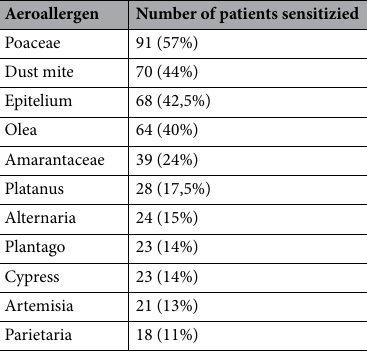
Table 3. Objectified sensitizations to